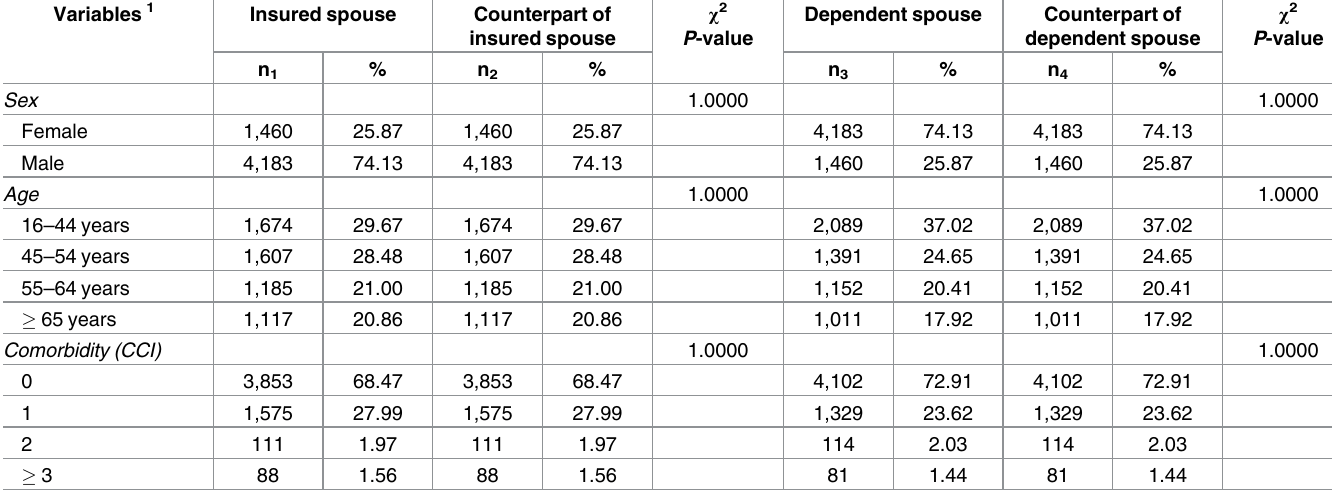
Table 1. Comparisons of characteristics after 1:1 dual propensity score matching for couples and noncouples (N = 11,286 pairs). Variables